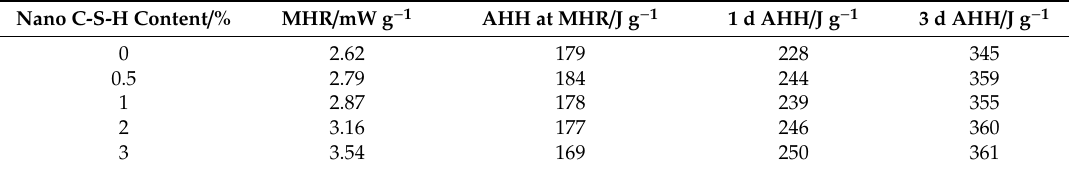
Table 3. Results of Accumulated Hydration Heat.